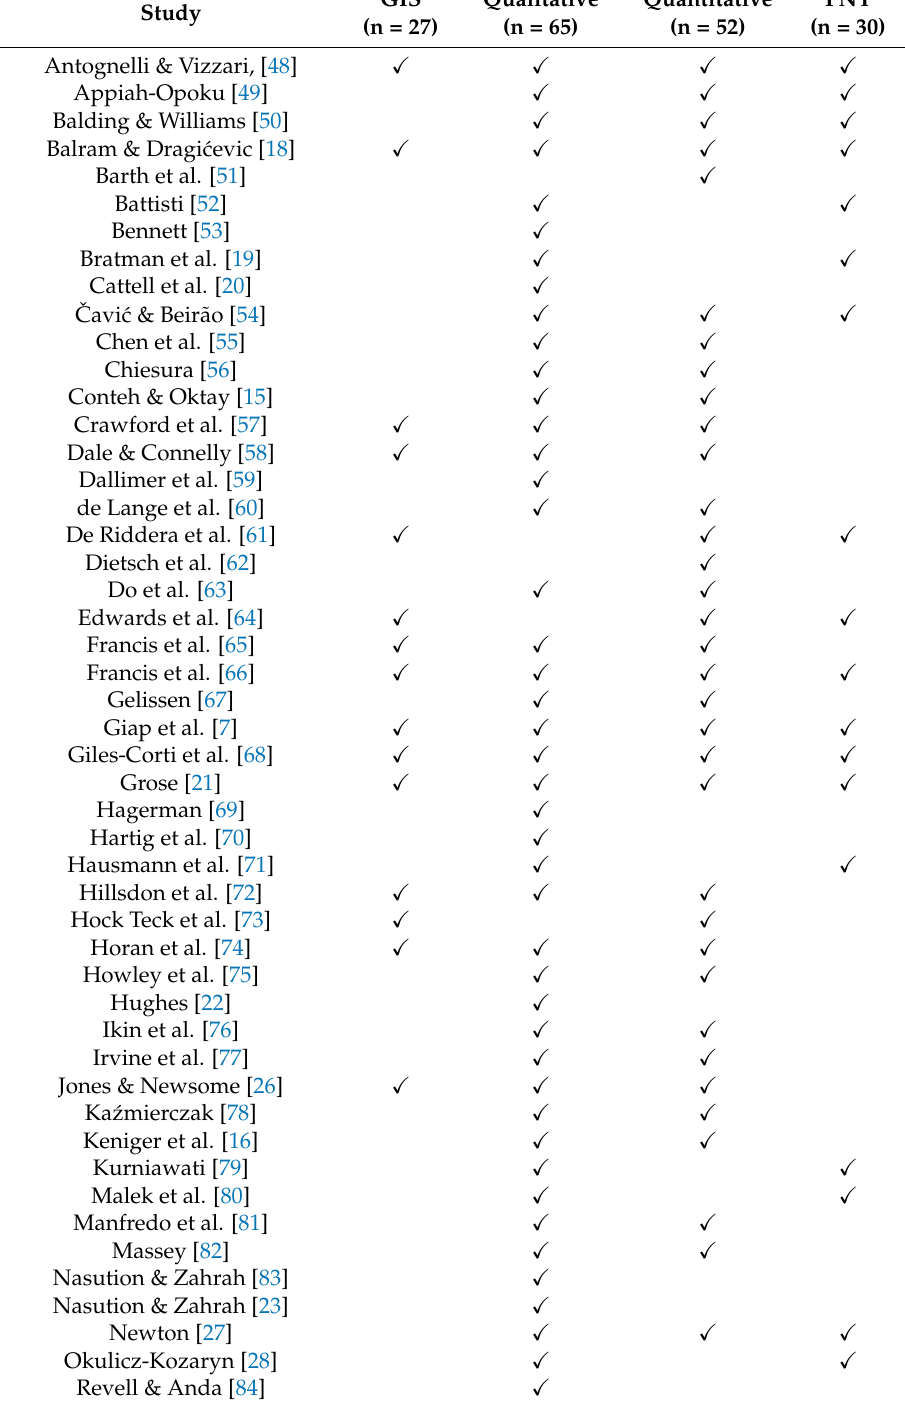
Table 2. Research approaches utilized, validated, or recommended under each category by